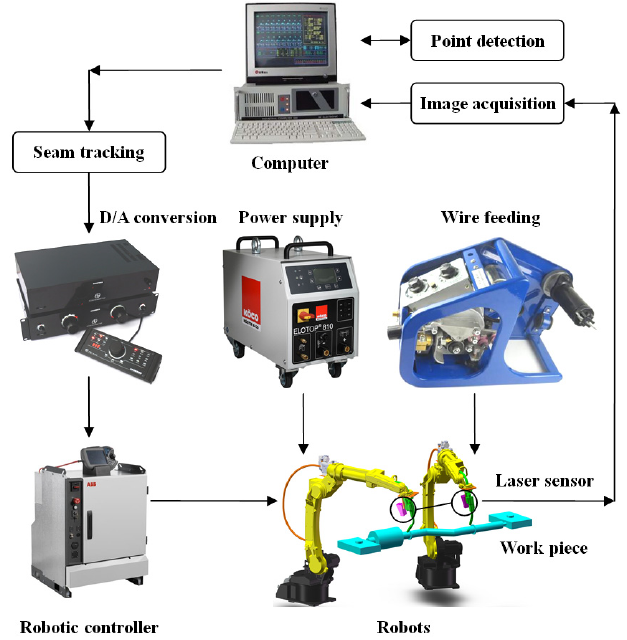
Figure 1. Diagram of seam tracking system.